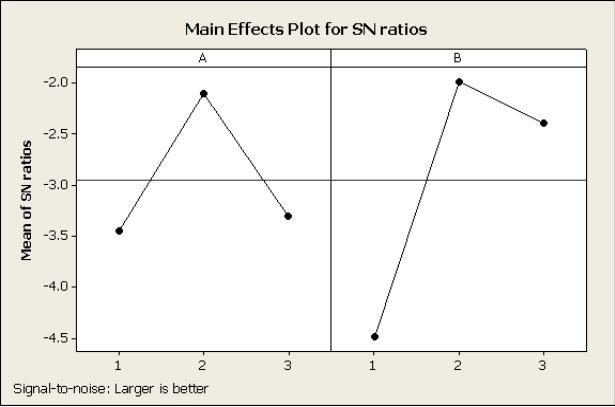
Fig. 8 . Main effect plot for S/N